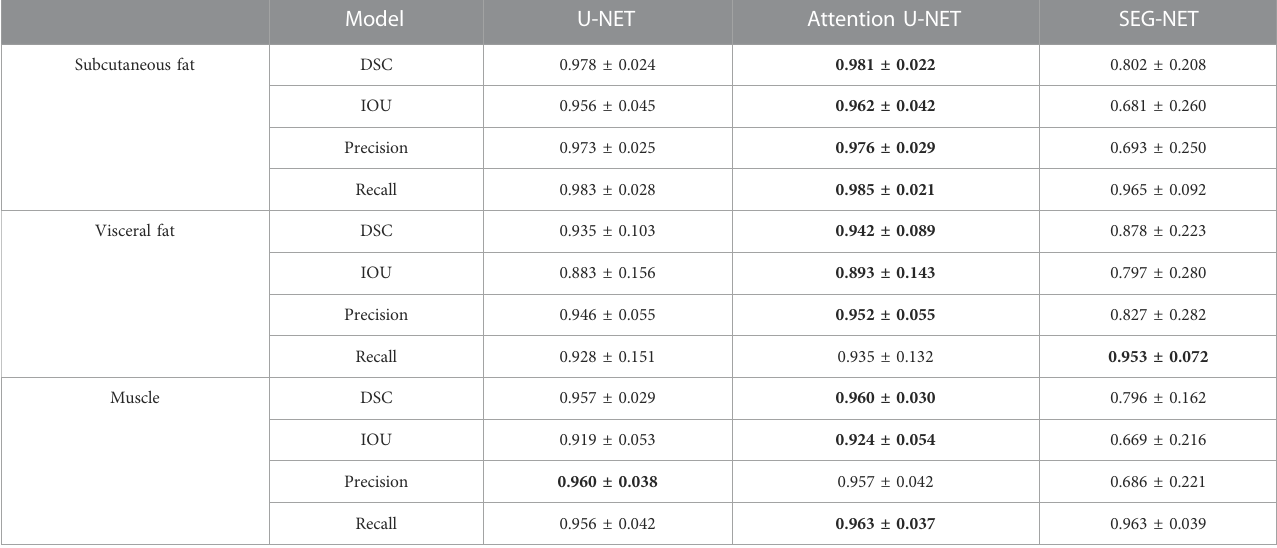
TABLE 2 Statistics of agreement between manual and automatic segmentations in the developmental test dataset.